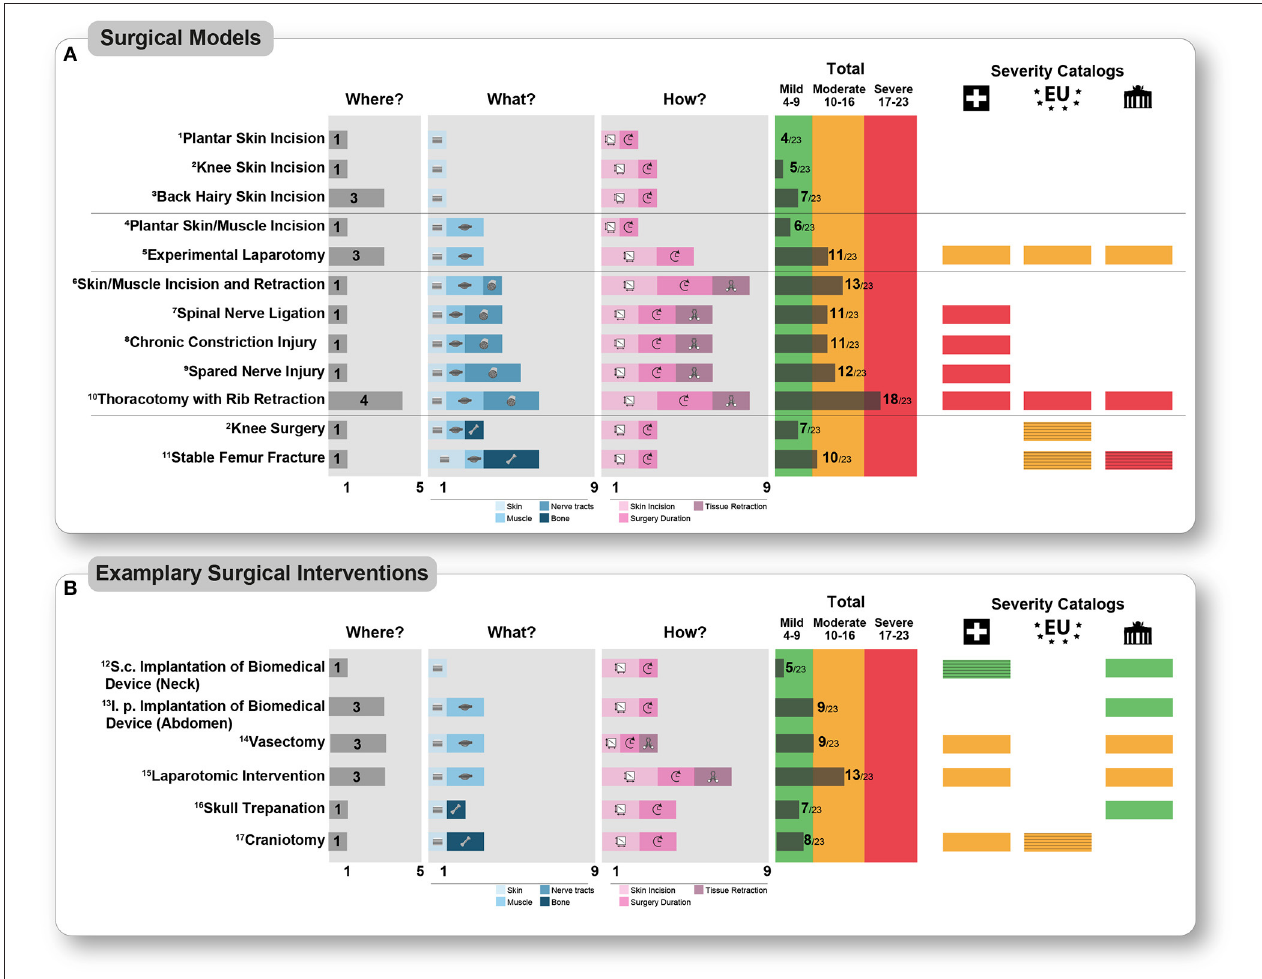
FIGURE 3 | Detailed presentation of the scoring according to the WWHow concept of different pain models (A) and exemplary surgical interventions in biomedical research (B). The corresponding scoring is presented for each intra-operative parameter according to the WWHow concept. The individual factors are displayed pictographically for the “What” (blue shades) and “How” (magenta shades) categories according to the scoring. The total score is illustrated for each surgical intervention without any analgesia treatment and categorized into “mild” (green color, score 4–9), “moderate” (orange color, score 10–16), and “severe” (red color, score 17–23). On the right part of the figure, the severity assessment according to three widely used catalogs, namely the Swiss (Swiss symbol), the EU (EU symbol), and Berlin animal welfare (Brandenburger Tor symbol), are labeled in the corresponding colors if the interventions are listed there. The grading was represented by striped colors if a similar intervention was found. If no corresponding intervention was found in the catalogs, this position is white. 1 Pogatzki and Raja (42); 2 Buvanendran et al. (49); 3 Duarte et al. (50); 4 Brennan et al. (43); 5 Kendall et al. (51); 6 Flatters (30); 7 Ho Kim and Mo Chung (52); 8 Bennett and Xie (53); 9 Decosterd and Woolf (54); 10 Buvanendran et al. (46); 11 Jimenez-Andrade et al. (55); 12 Lu et al. (56); 13 Ren et al. (57); 14 Awsare et al. (58); 15 Zieglowski et al. (59); 16 Llovera et al. (60); 17 Kyweriga et al.